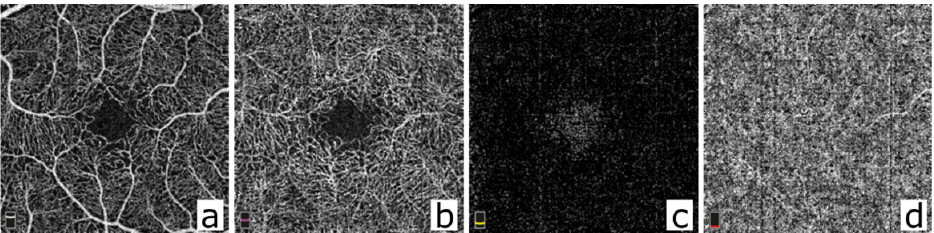
Figure 1. Segmented OCT-A 3 × 3 mm volume scan (304 × 304 A-lines) of a healthy central retina (macula). ( a ) OCT-A scan of the normal superficial capillary plexus located in the ganglion cell layer. The foveal avascular zone (FAZ) is spared by the ramifying vessels. ( b ) OCT-a scan of the normal deep capillary plexus located between the inner nuclear layer and the outer plexiform layer. The vessels form a complex, regular network, and the FAZ is spared. ( c ) OCT-A scan of the normal outer retina. The outer retina is avascular in the healthy eye. ( d ) OCT-A scan of the normal choriocapillaris showing a fine, granular texture. (Scans obtained with Optovue Angio Vue with OCT scanning speed of 70.000 A-scans per